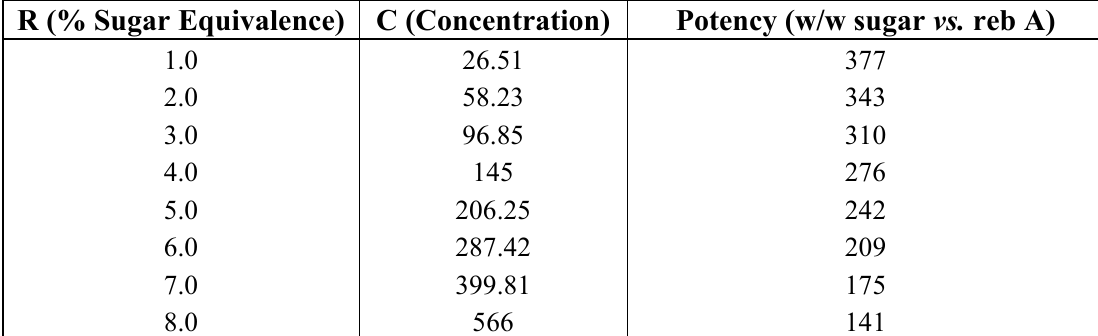
Table 1. Sweetness potency data of reb